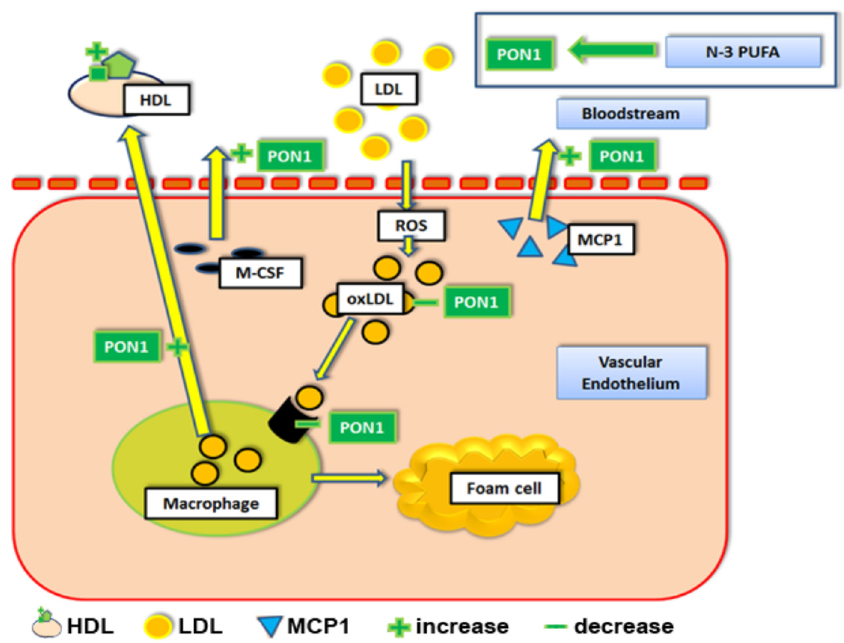
Figure 3. The effects of n-3 PUFAs on paraoxonase 1 and cholesterol efflux. Abbreviations: HDL = high density lipoprotein particle. LDL = low density lipoprotein. PON1 = paraoxonase 1. MCP1 = Monocyte chemotactic protein 1. ROS = reactive oxygen species. M-CSF = macrophage colony stimulating factor. oxLDL = oxidized LDL. n-3 PUFA = Omega 3 polyunsaturated fatty acid.